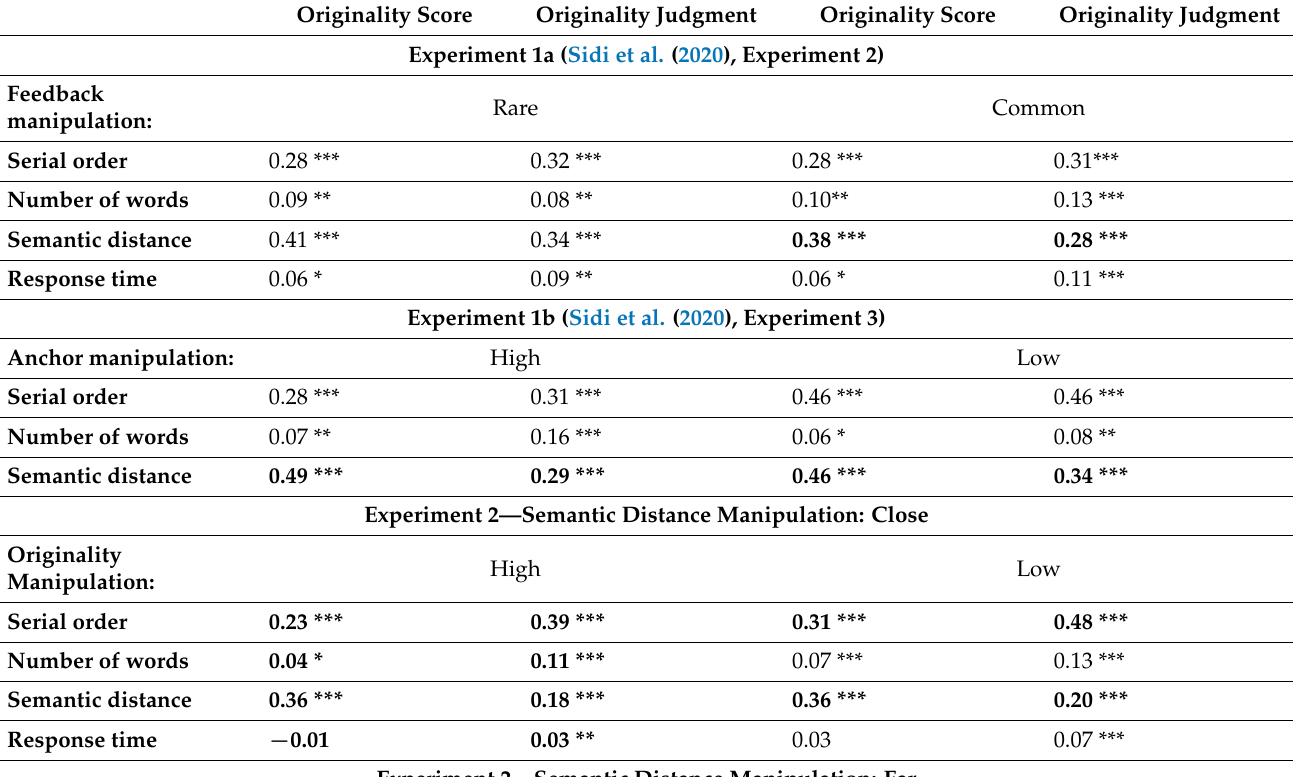
Table 1. BEVoCI β coefficients representing cue validity in predicting originality scores and cue utilization for originality judgments in all conditions in Experiment 1 and Experiment